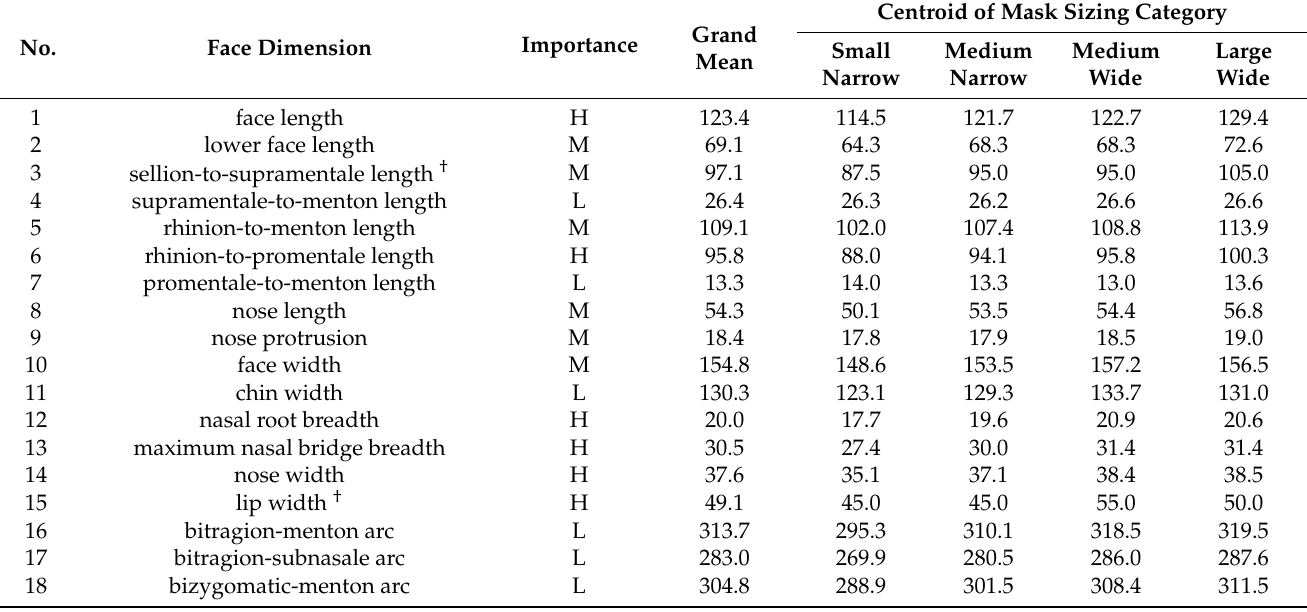
Table 2. The medians (key dimensions) and averages of face measurements by mask sizing cate- gory (unit: